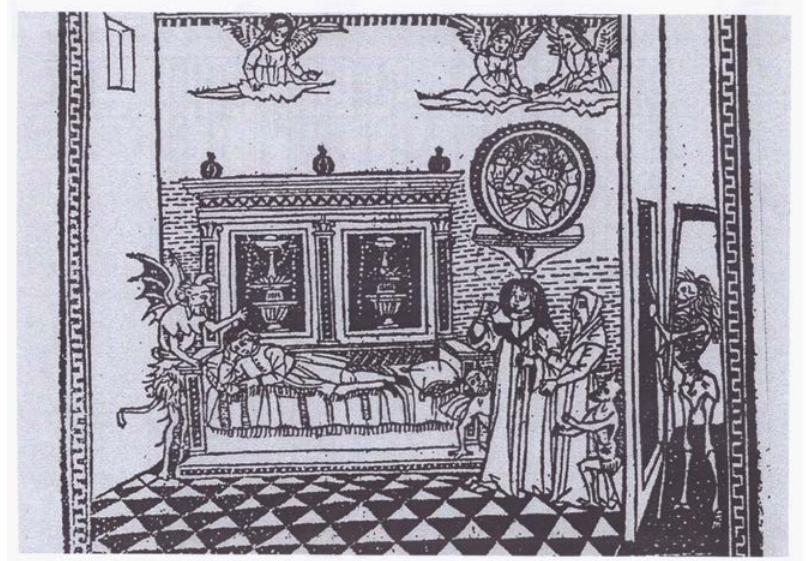
Figure 6 – Girolamo Savonarola, Predica dell’arte del Bene morire , s.n.t. [but Firenze, Bartolomeo de’ Libri, after november 2, 1496), f. 12r (BNCF, Cust. E 6). By permission of Ministero per i beni e le attività culturali / Biblioteca Nazionale Centrale. Firenze